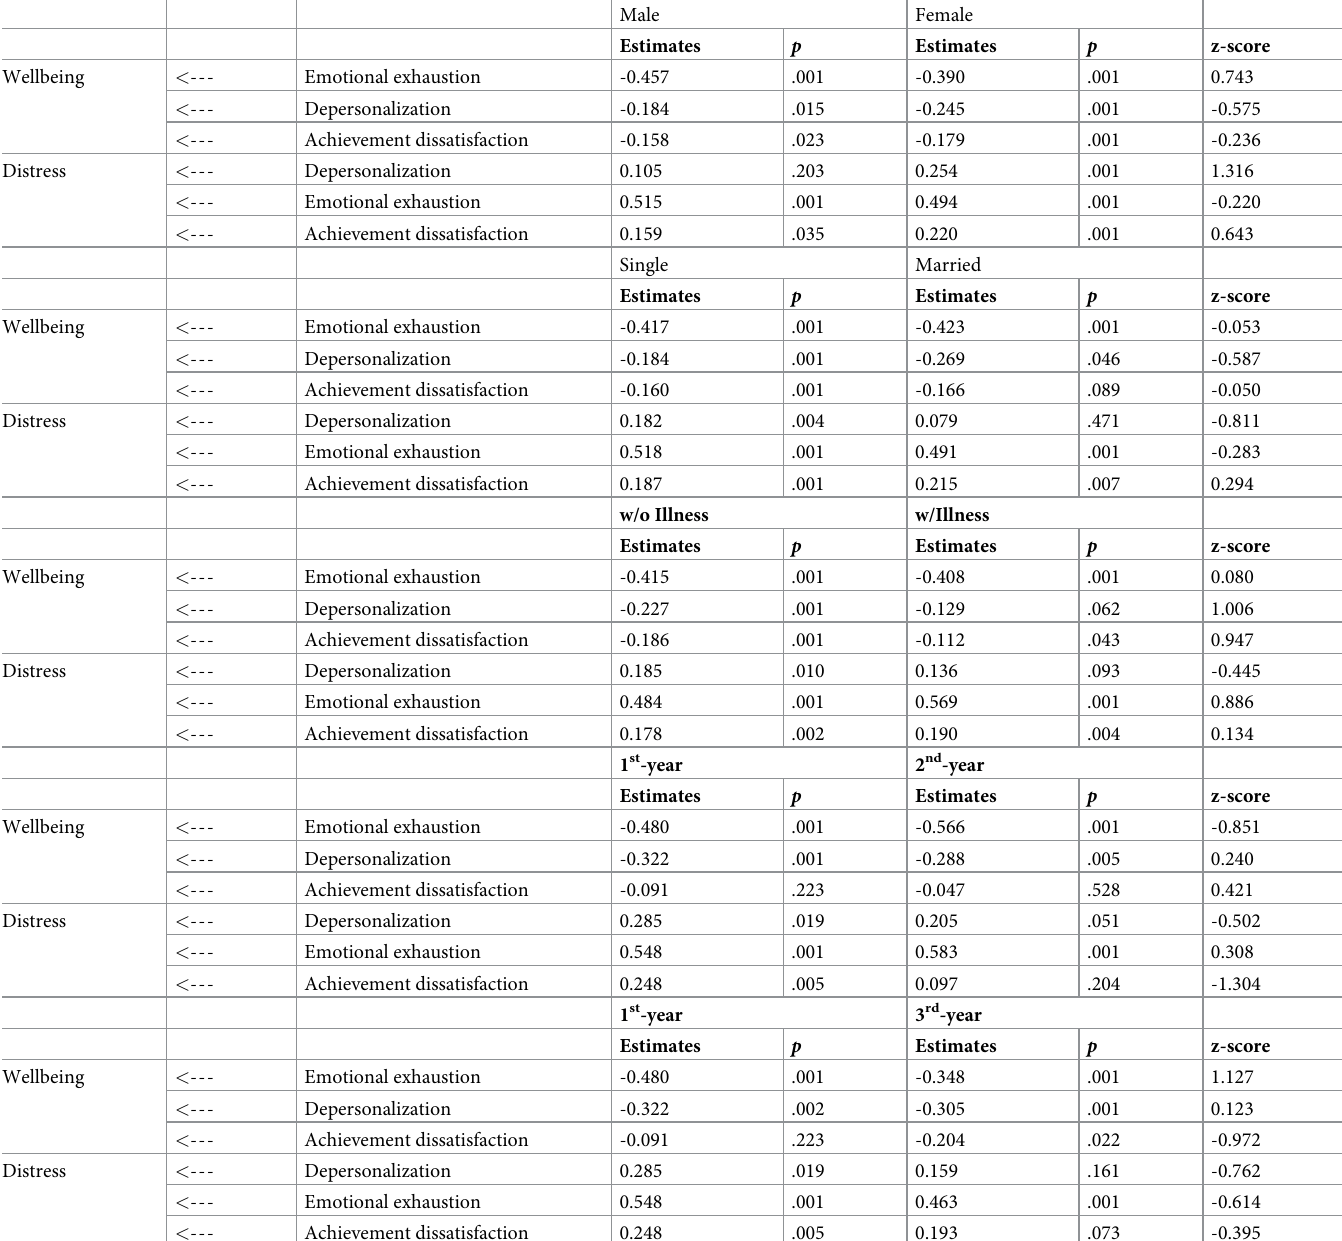
Table 4. Pairwise contrast on the estimates of the sociodemographic variables for the path